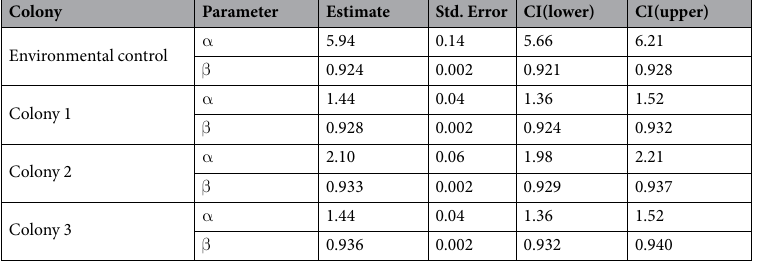
Table 1. Estimates of basic number of exits ( α ) and auto-correlation parameter ( β ) from the autoregressive conditional Poisson model. The α and β parameters were indicated with their standard errors and lower and upper bounds of their confidence intervals at 95% for each colony.